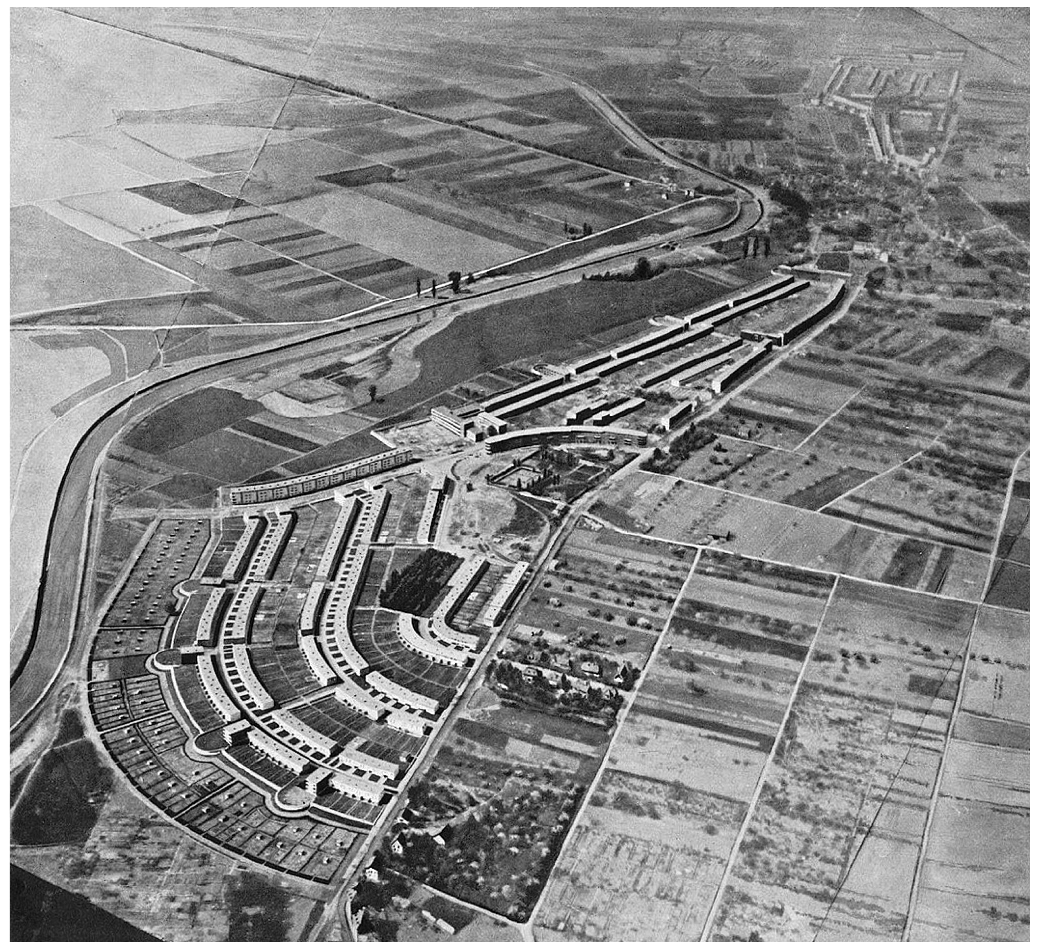
Figure 2. Aerial view of the Nidda valley with the Siedlung Römerstadt in foreground and the Siedlung Praunheim in back- ground. Source: Das neue Frankfurt